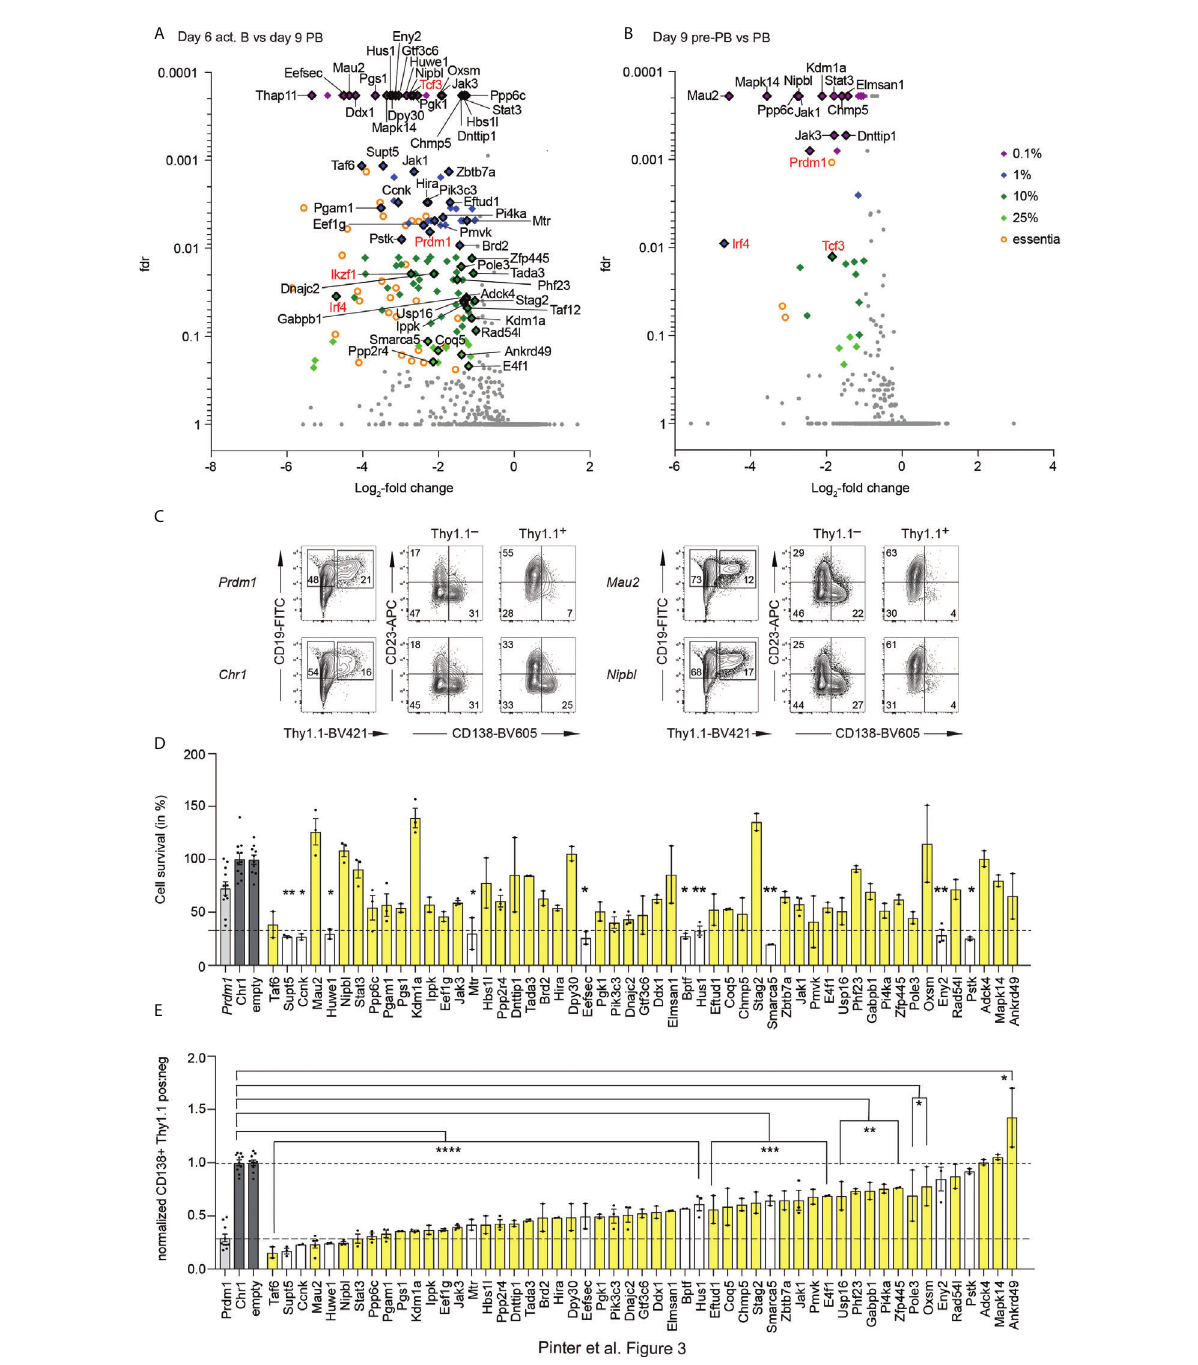
FIGURE 3 Results of screen 2. (A, B) Volcano blot of the screen 2, depicting interesting hits in the comparison of the act B from day 6 versus the PBs from day 9 (A) and the pre-PBs versus the PBs from day 9 (B) , as in Figure 1G. Fdr = false discovery rate. Factors which are known to be essential for PCs are highlighted in red. (C) Example of single guide validation. Control Chr1 is targeting a gene free region on Chromosome 1. (D, E) Single guide validation. Cell survival was determined by the ratio of the amount of Thy1.1 + cells on day 6 versus day 9, normalized to Chr1 and the empty vector (the plasmid without any sgRNAs). Stars indicate signi fi cant difference compared to Chr1 (D) . The ratio of the amount of PBs in the Thy1.1 negative and positive population was calculated and normalized to the average of the value of the negative controls Chr1 and empty vector to determine the impact of the sgRNA on the PBs (E) . One or two best performing single sgRNAs from the screen were used. Each dot represents one replicate. Genes colored in white showed reduced survival in (D) . All statistical data are shown as mean values with SEM; *P < 0.05; **P < 0.01; ***P < 0.001; ****P < 0.0001 (Student ’ s t